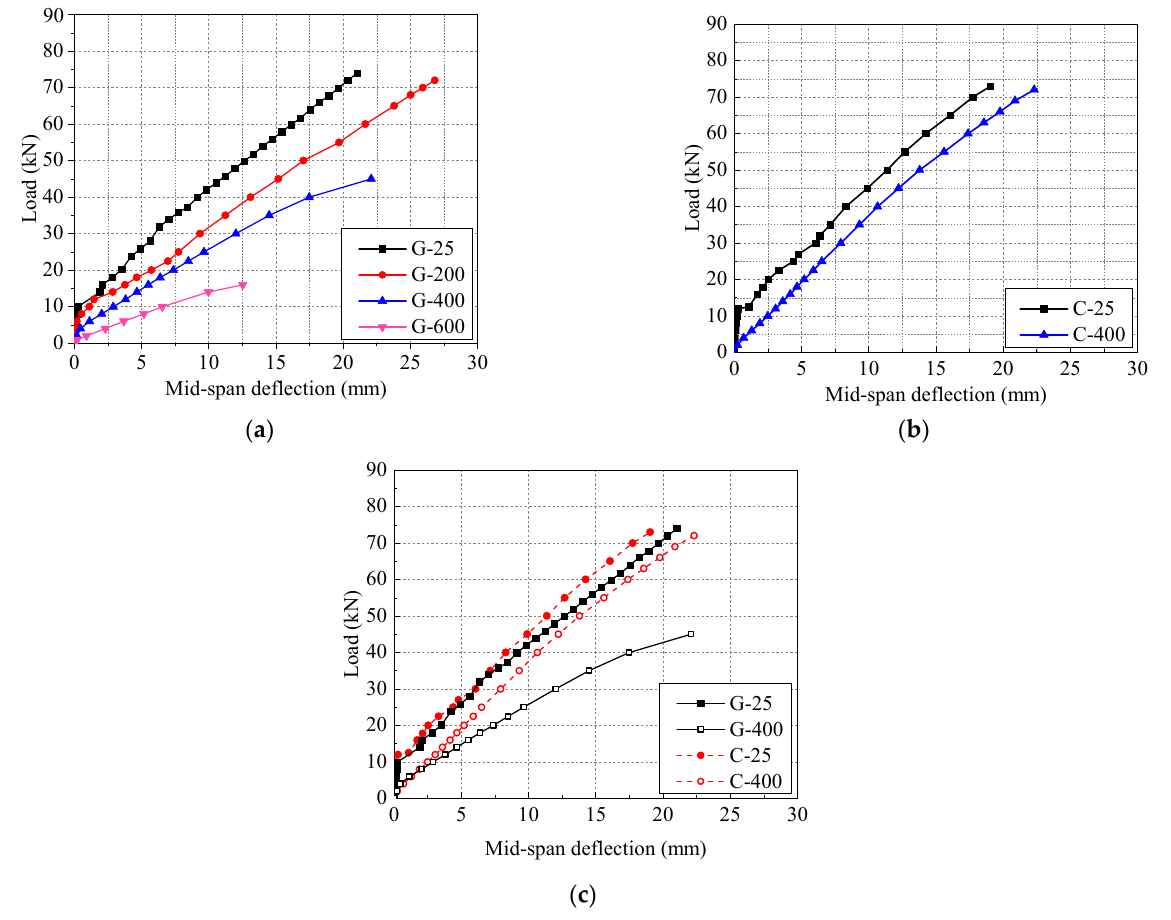
Figure 9. Load-deflection relationship for concrete beams with different FRP bar types after elevated temperature exposure: ( a ) effect of temperature of GFRP bar; ( b ) effect of temperature of CFRP bar; ( c ) effect of FRP bar type.